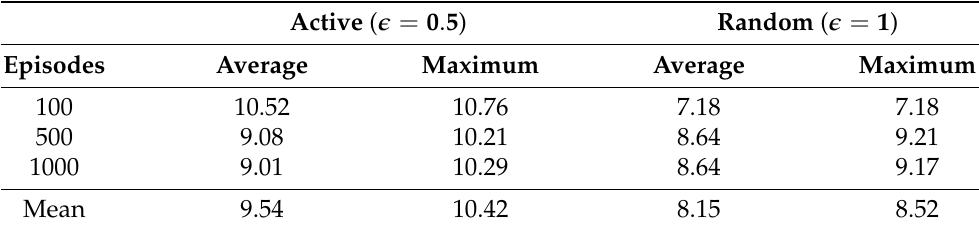
Table 5. Grade values for the positively graded weight sets by active and random exploration. One may notice the same average and maximum grades for (cid:101) = 1 with 100 episodes. This is due to the single positively graded weight set as resulted by the corresponding setting (Table